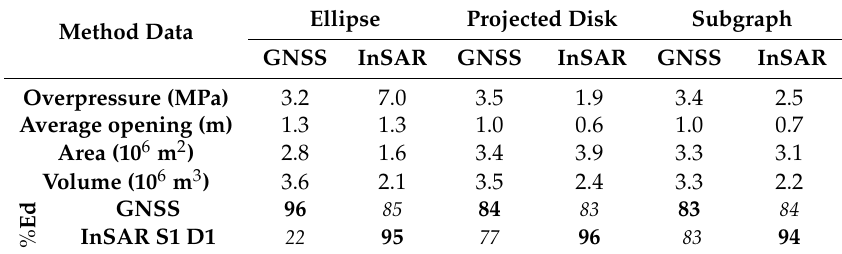
Table 4. Comparison of the inverted source characteristics for different methods for tracking magma propagation and different data: continuous GNSS data from the permanent network and an intermediate Sentinel-1 interferogram S1 D1 covering the first part of the eruption (before 01:45). % explained data (% Ed , see Equation (9)) computed with data used in the inversions are in bold, while those computed a posteriori using data omitted in the inversion are in small italics. Ellipse Projected Disk Subgraph Method Data